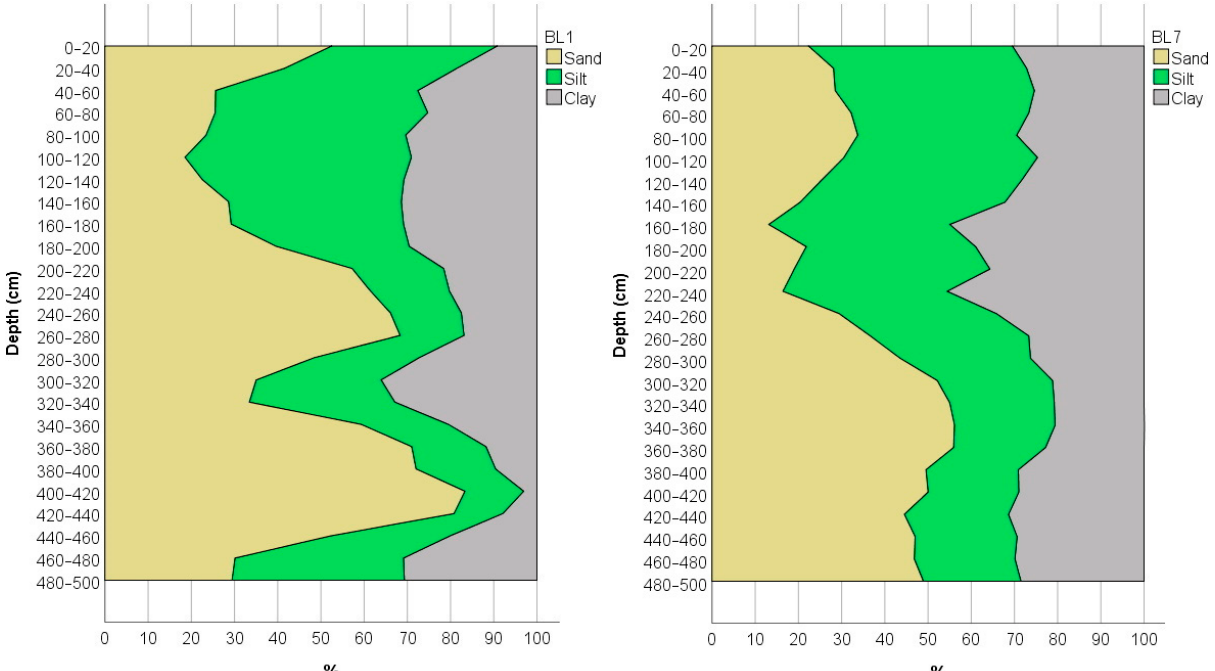
Figure 5. Texture of the borehole profile of the monitoring well BL1, located in the first disposal basin, and well BL7, located east from the disposal basins.